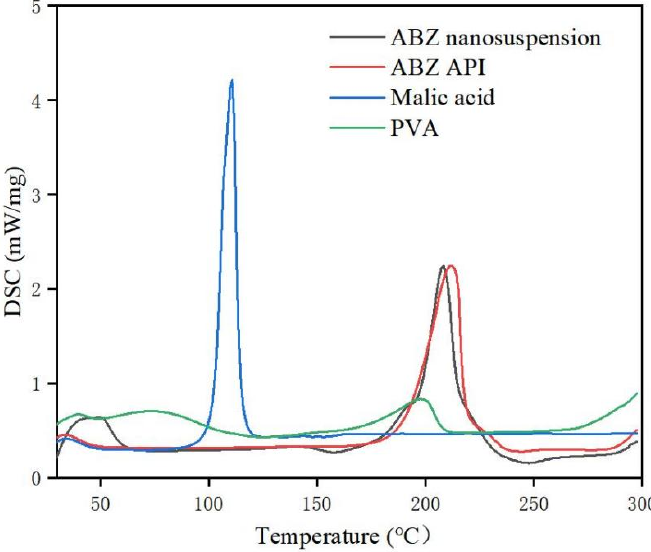
Figure 7. DSC of bulk drug and albendazole nanocrystals.